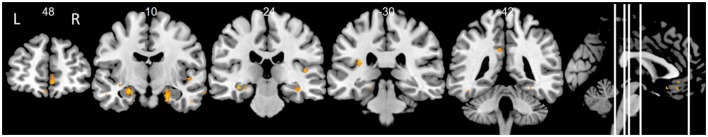
Positive associations of delayed primacy recall and left hippocampal functional connectivity. Controlled for age, gender, and education. Maps were thresholded at significance level p < 0.01 (uncorrected for multiple comparisons), cluster size ≥ 20 voxels.